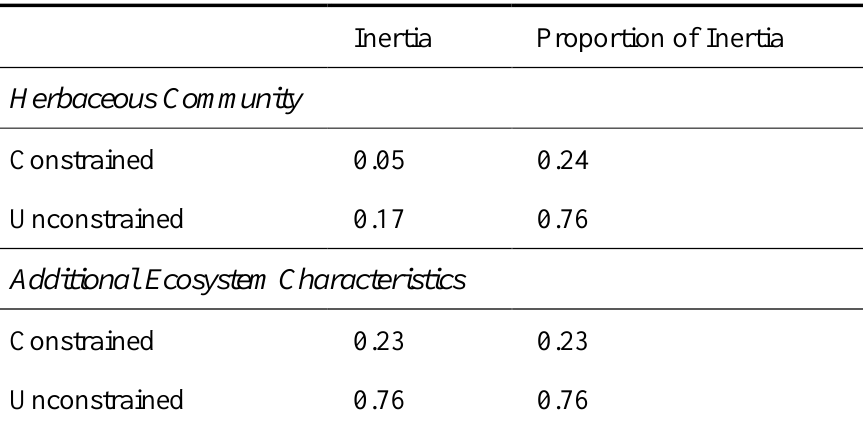
Table A1.2. Inertia and the proportion of inertia that was constrained versus unconstrained in two redundancy analyses on community and structural data collected in 2015 and 2016 within and surrounding the perimeter of the 1989 Fort Robinson wildfire, Nebraska, USA across a range of transition classes. Transition classes were used as predictor variables and were composted of fire severity (unburned, low severity, or high severity) and the ecological regime (grassland or forest) that occurred prior to the fire. Italicized titles represent the data used in redundancy analyses, where “Herbaceous Community” indicates RDA outputs with herbaceous plant community data and “Additional Ecosystem Characteristics” indicates RDA outputs with understory woody plant height and cover, bird species presence, coarse woody debris cover, and snag